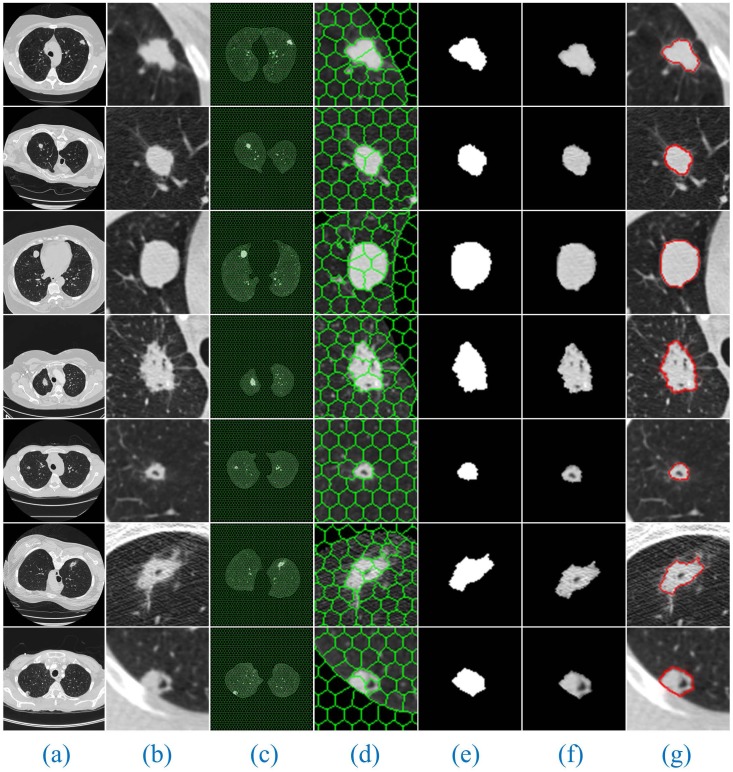
The segmentation results of our method for solitary pulmonary nodules and cavitary nodules.Column (a) shows the original lung CT images, (b) shows the results of the local enlargement of (a), (c) shows the segmentation results of HMSLIC, (d) shows the results of the local enlargement of (c), (e) shows the lung nodule image masks obtained by the Improved DBSCAN algorithm, and (f) and (g) present the final results using our method and manual segmentation by experts.